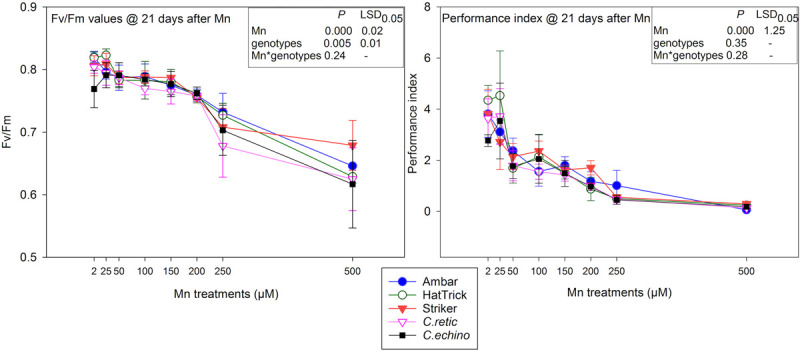
Fv/Fm values and performance index (PI) of five Cicer genotypes in eight Mn treatment levels measured at 21 days after Mn additions. Vertical bars where visible represent the standard error of the mean.